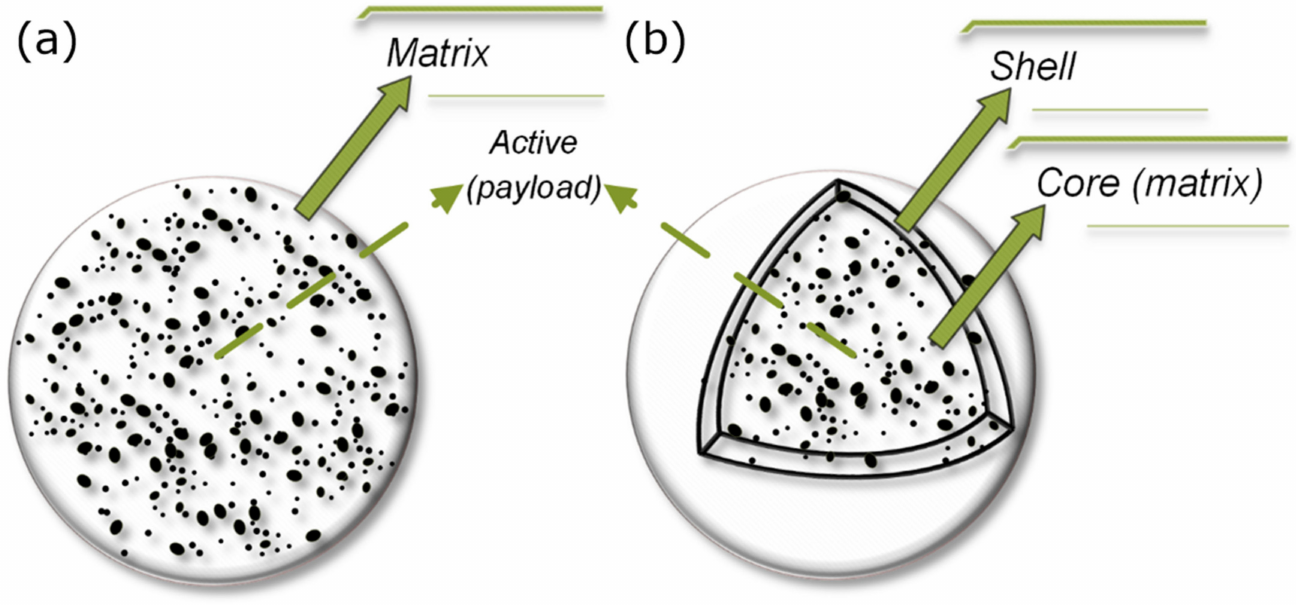
Figure 1. Schematic representation of main forms for active substance encapsulation: ( a ) matrix type ( sphere ) and ( b ) core-shell type ( capsule